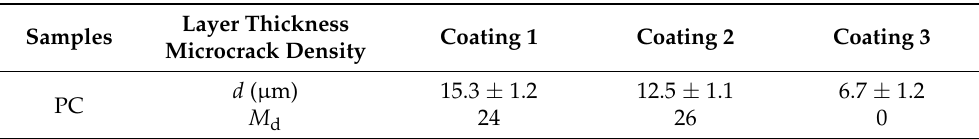
Figure 6. Near-surface pH in Fe-Cr-Ni electrolyte (fresh: first 30 min, used: second 30 min) over a period of 30 min for PC at 12 A/dm 2 . Table 5. Layer thicknesses d and microcrack density M d (number of cracks per 1000 µ m) of PC coatings determined by optical